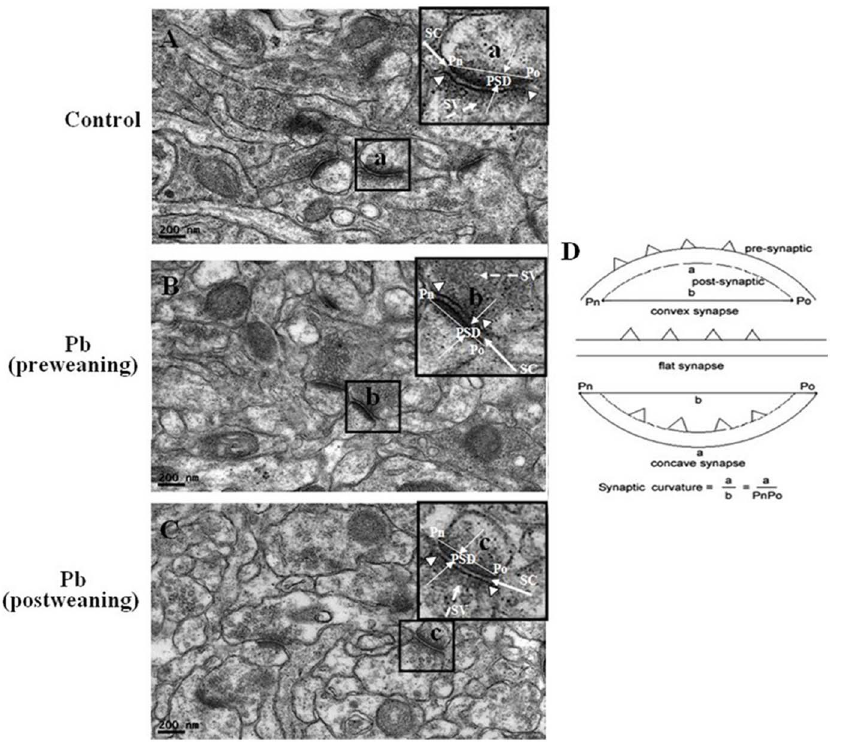
Fig. 3. The synaptic structure in the CA1 region of rat hippocampus at postnatal day 90 was observed under transmission electron microscopy (37,000x). The synaptic structural parameters were measured as described in the section of Materials and Methods. Also, the synaptic structural parameters of control (A), Pb (pre-weaning) (B), and Pb (post-weaning) group (C) were compared in Table 5. The ultrastructural features of synapses (insets a–c) in three groups (A, B, C) and the synaptic curvature measurement (D) were illustrated. The length of synaptic active zone was indicated by two arrowheads. The thickness of postsynaptic density (PSD) was at the thickest part of PSD and limited by two long arrowheads; Po and Pn showed the synaptic curvature measurement points; SC represents the synaptic cleft; SV represents synaptic vesicles.